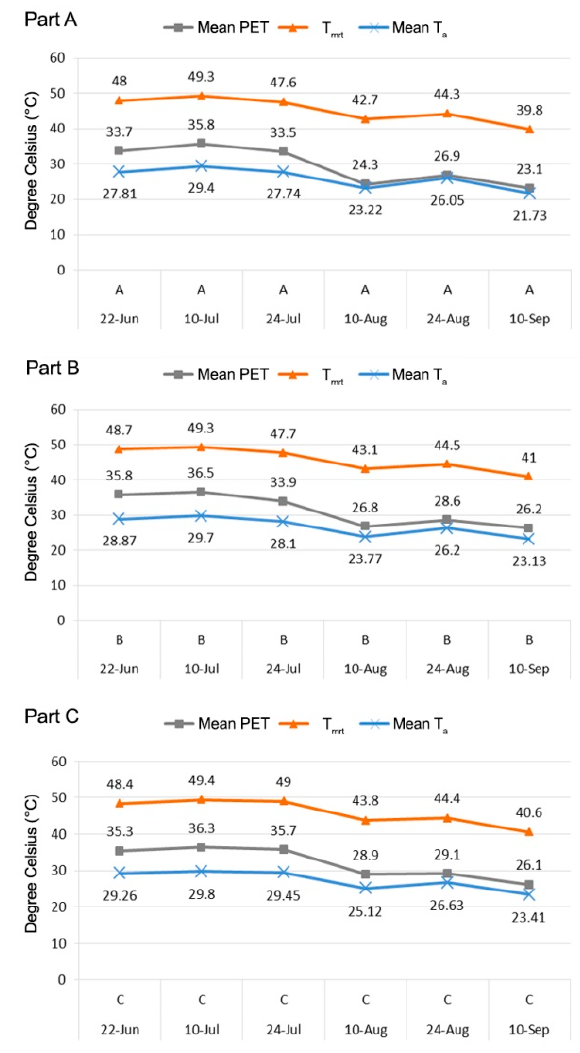
Figure 8. The relationship among mean PET (gray), mean T a (blue) and T mrt (orange), at each three intersections A, B and C during six days.